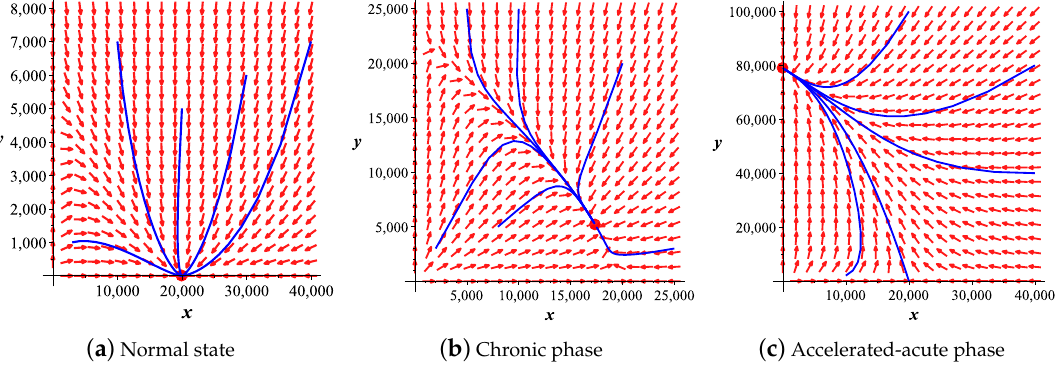
Figure 2. Phase portrait of the two-dimensional system (4)–(5), in the normal state ( a ) D < d ; in the chronic phase ( b ) d < D < ( b 1 / b 2 ) d ; and in the accelerated-acute phase ( c ) ( b 1 / b 2 ) d < D . The orbits ( x ( t ) , y ( t )) approach the unique asymptotically stable equilibrium (represented by a thickened red point): ( d ,0 ) , in case ( a ); ( x ∗ , y ∗ ) , in case ( b ); ( 0, D ) , in case ( c